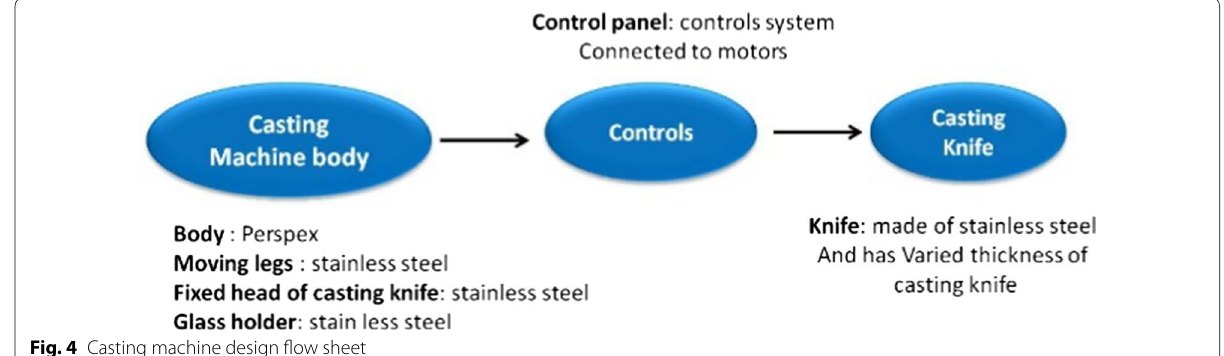
Fig. 4 Casting machine design flow sheet